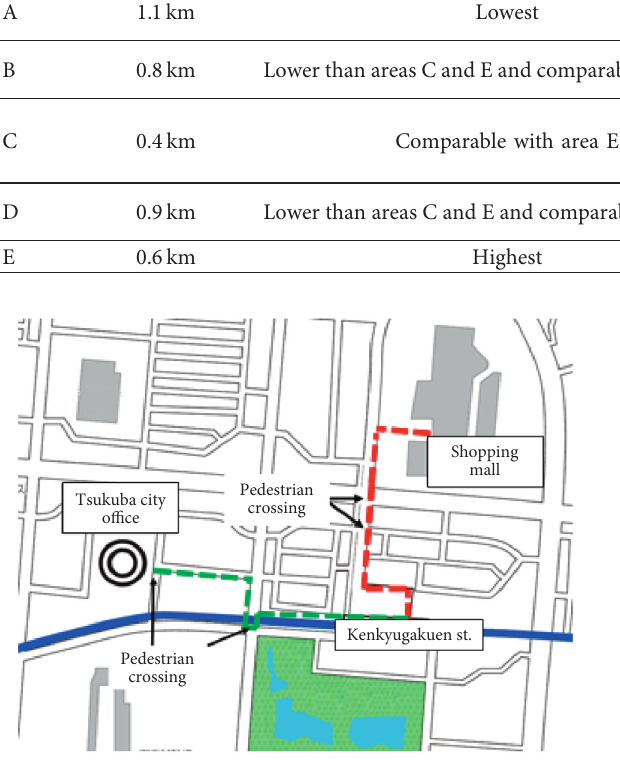
Figure 3: Experimental routes for Scenarios 2 and 3 (dashed green line: route for Scenario 2; dashed red line: route for Scenario